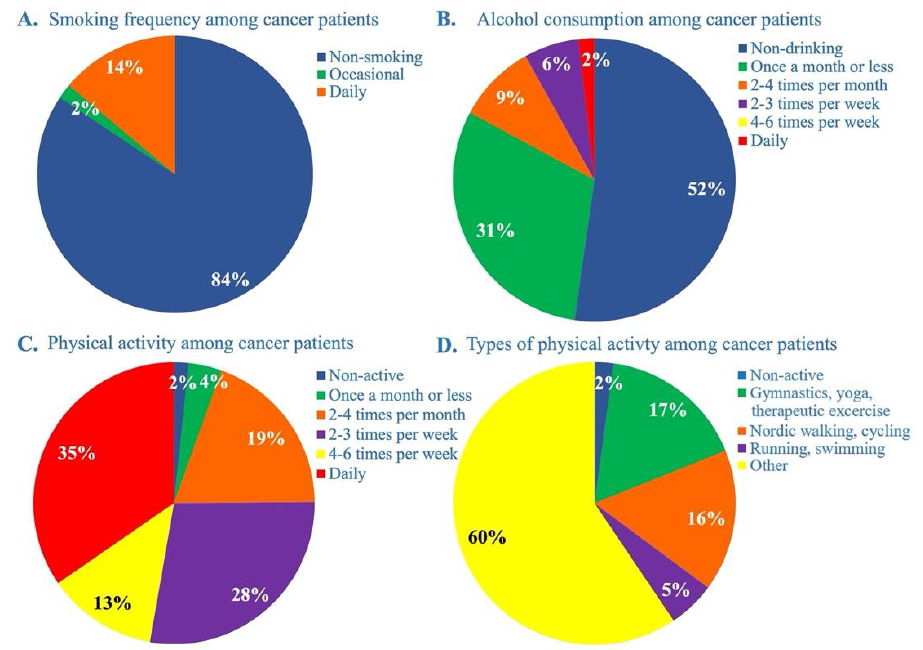
Figure 1. Smoking and drinking habits, and physical activity in cancer patients. ( A ) Frequency of smoking, ( B ) frequency of alcohol consumption, and ( C , D ) frequency of physical activity and types in cancer patients.